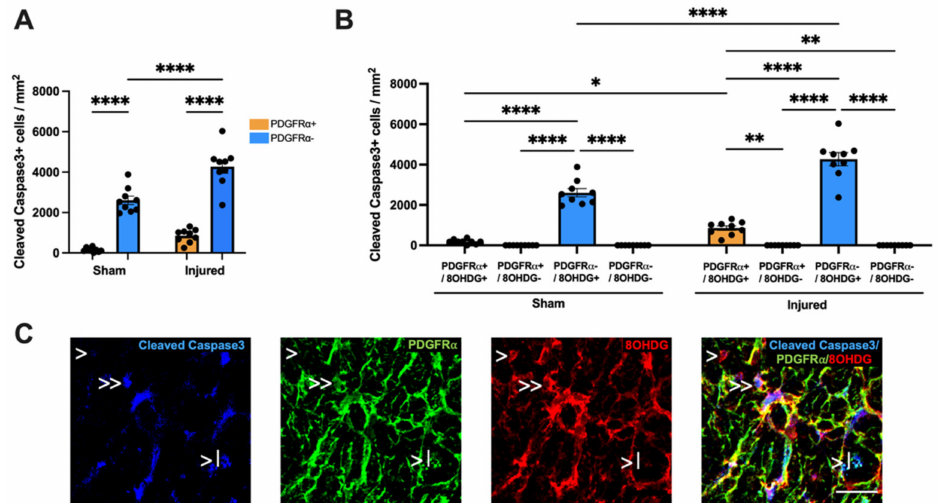
Figure 6. Effect of injury on apoptosis and oxidative DNA damage of OPCs. ( A ) The relative densities of Cleaved Caspase3+ PDGFR α + and Cleaved Caspase3+ PDGFR α − OPCs were quantified. Statistical analysis by two-way ANOVA and Tukey post hoc tests. ( B ) The relative densities of Cleaved Caspase3+ cells colocalized with PDGFR α and 8OHDG were quantified. Statistical analysis by three-way ANOVA with Tukey post hoc tests. Graphs display individual data points overlaid on a bar displaying the mean ± SEM. n = 9 rats per group. ( C ) Representative image illustrating Cleaved Caspase3+ PDGFR α + 8OHDG+ cells (indicated by >>), Cleaved Caspase3+ PDGFR α + 8OHDG − cells (indicated by >|) and Cleaved Caspase3+ PDGFR α − 8OHDG+ cells (indicated by >) is shown. Cleaved Caspase3+ PDGFR α − 8OHDG − cells were not observed in the ventral nerve. Scale bar = 25 µ m. No outliers were removed for any outcome measure. Significant differences are indicated by * p ≤ 0.05, ** p ≤ 0.01, **** p ≤